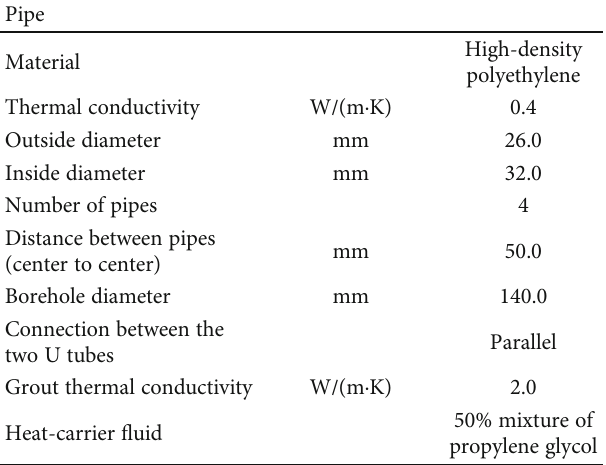
Table 5: Characteristics of the double U-tube heat